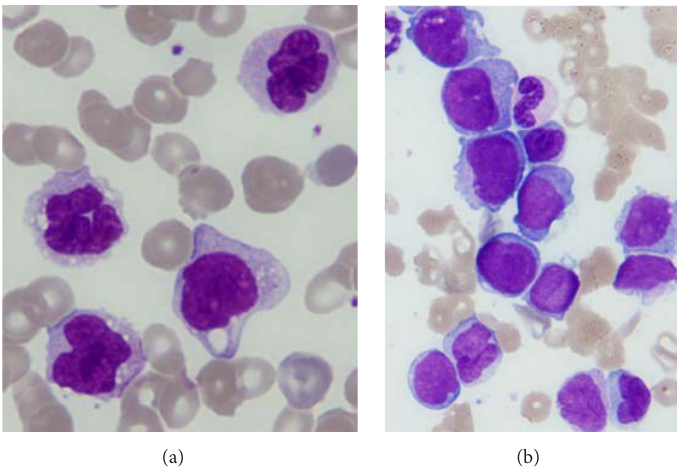
Figure 4: May-Gr¨unwald-Giemsa stained smears of peripheral blood and bone marrow show mature monocytes and promonocytoid cells with folded nuclei in the peripheral blood (a) and immature blast and promonocytoid cells in the bone marrow (b) (original magnification ×